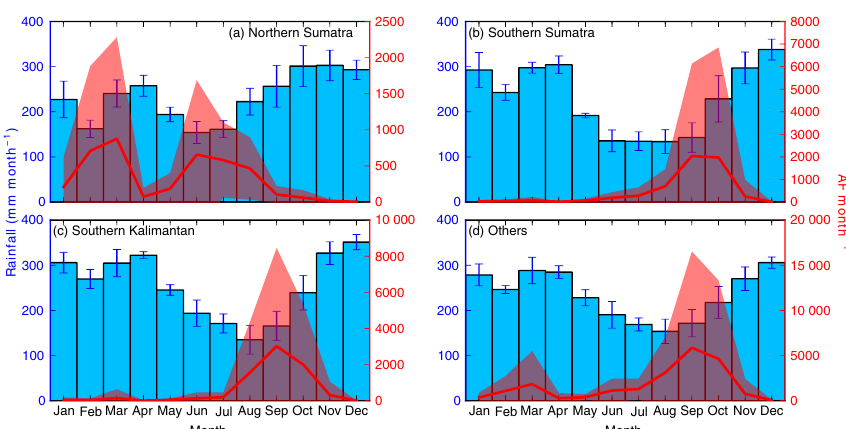
Figure 4. Monthly rainfall with standard deviation (blue) and active fire detections (AF) with standard deviation (red), averaged over 1997– 2015.